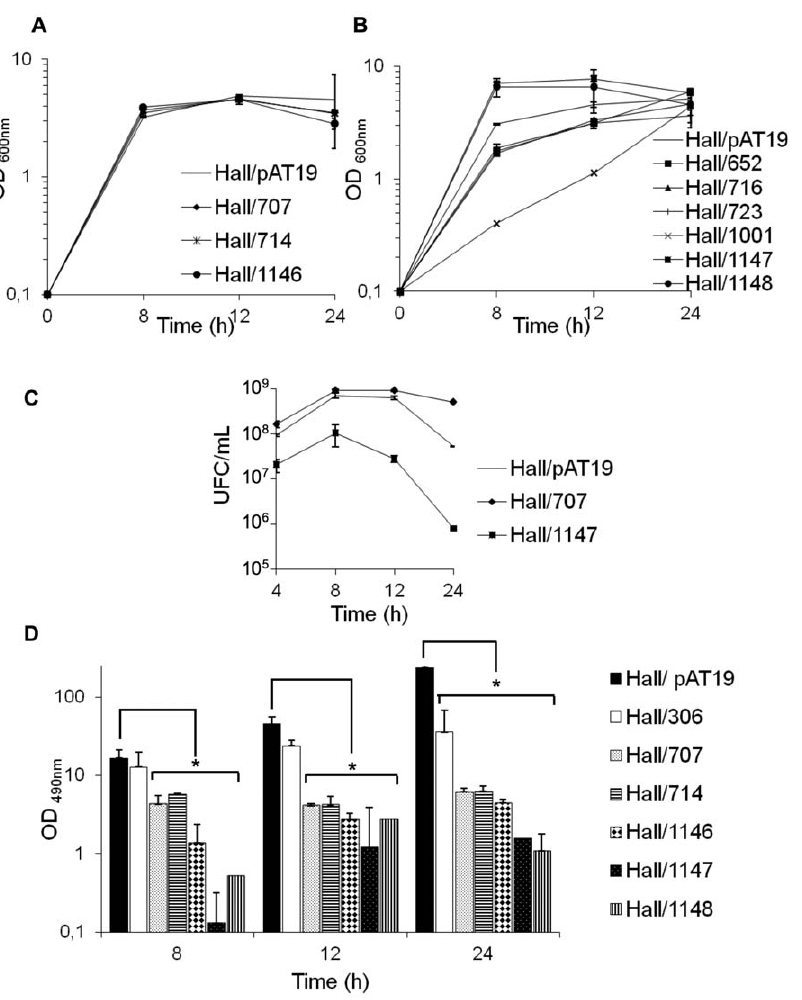
Figure 3. Growth kinetics and BoNT/A production in representative Hall isogenic antisense strains. (A) Hall/707, Hall/714, and Hall/1146 showed a similar growth curve monitored at OD 600 than the Hall/pAT19 strain. (B) Hall/1147 and Hall/1148 grew more rapidly than the control Hall/ pAT19 strain, whereas Hall/1001 displayed a slower growth curve. Hall/652, Hall716, and Hall/723 show a similar kinetics compare to Hall/pAT19. (C) Monitoring of growth kinetics of Hall/pAT19, Hall/707 and Hall/1147 by bacterial counting on TGY agarose and expressed as unit forming colony (UFC)/ml. (D) BoNT/A production assayed by ELISA was significantly reduced in the culture supernatants of Hall/707, Hall/714, Hall/1146, Hall/1147, and Hall/748, versus the control Hall/pAT19 strain. BoNT/A production was significantly reduced in Hall/306 at 24 h culture. Data are mean values + / 2 SD from 3 independent experiments, *P , 0.05. doi:10.1371/journal.pone.0041848.g003 Table 3. BoNT/A production tested by mouse bioassay in 12 h culture supernatants of the control strain Hall/pAT19 and isogenic antisense